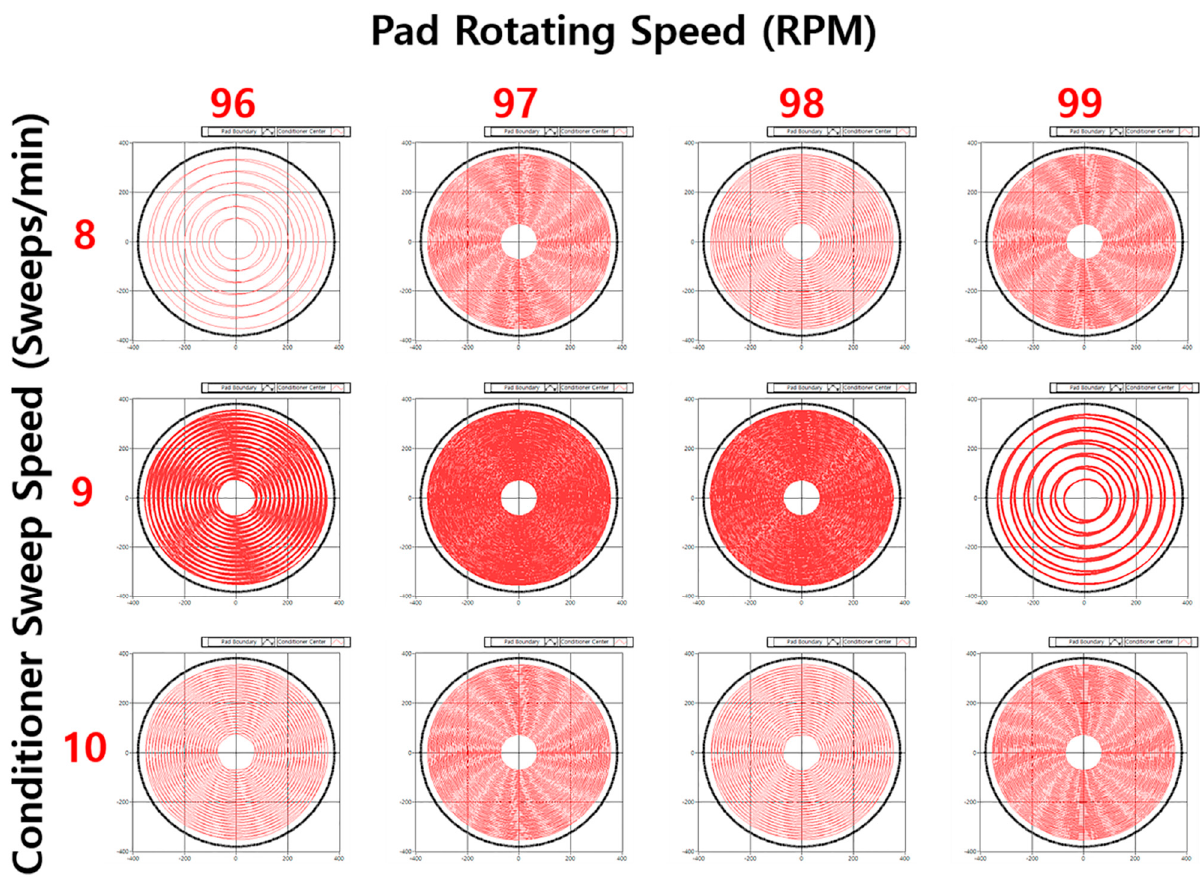
Figure 6. Conditioner disc center trajectory on the pad with respect to pad rotation speed and conditioning arm swing speed.